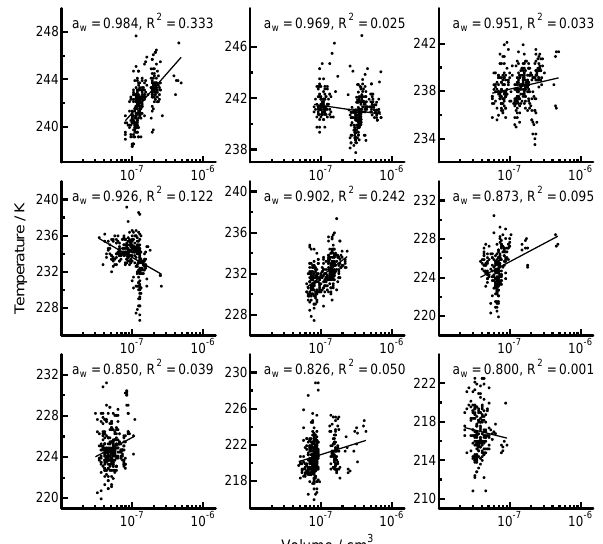
Fig. 5. Heterogeneous freezing temperatures of aqueous NaCl/diatom droplets shown as dots are plotted as a function of droplet volume for each investigated water activity. The solid lines represent best fits to the data. The coefficient of determination, R 2 , indicates the quality of the corresponding